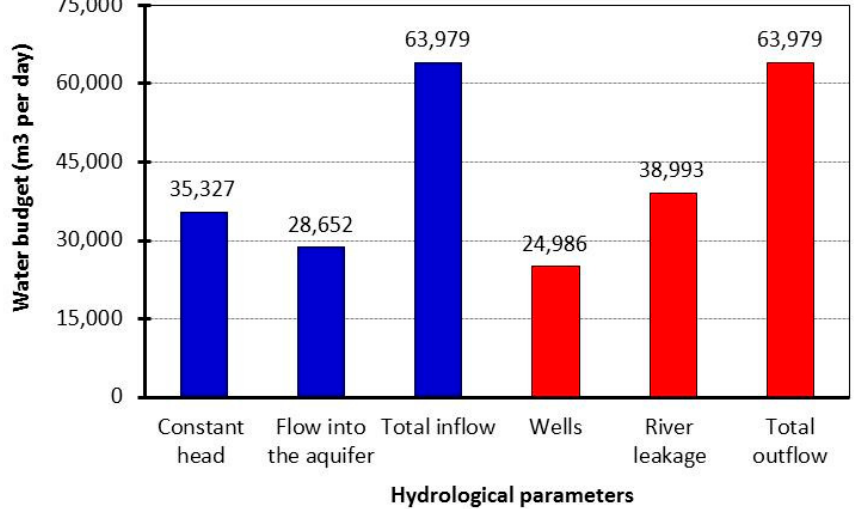
Figure 10. The total inflow and the total outflow in the study area of Aswan city.